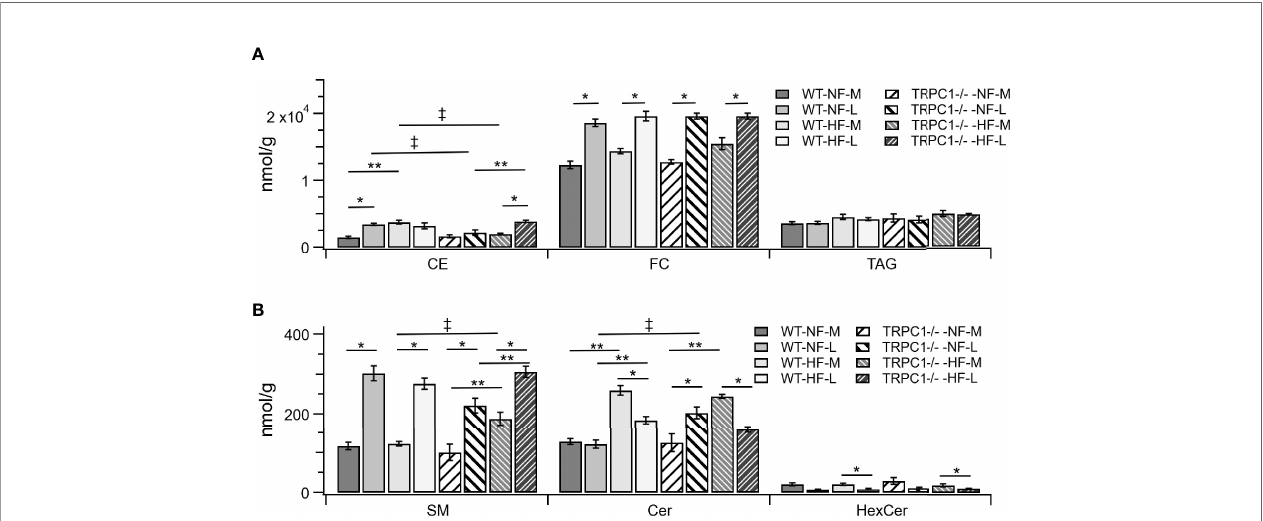
FIGURE 2 | Lipid class differences between groups for (A) cholesterol esters (CE), unesteri fi ed cholesterol (FC), triacylglycerols (TAG). Sphingolipids are shown in (B) , sphingomyelin (SM), ceramide (Cer), and hexosylceramides (HexCer). Data are shown as mean ± sem (n = 8, except for TRPC1 -/- -HF-M where n = 4). Symbols indicate differences with p<0.05 base upon one-way ANOVA with Tukey ’ s HRD post hoc test and application of a 0.05 false discovery rate for gestational age (*), diet (**), and genotype ( ‡ ). WT, wild-type; TRPC1 -/-, TRPC1 knock-out; NF, normal fat diet; HF, high-fat diet; M, mid-gestation; L, late